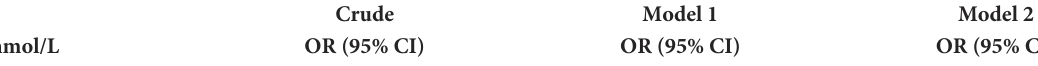
TABLE 3 Serum folate in relation to MAFLD according to vitamin C status. Crude Serum folate, nmol/L OR (95% CI) OR (95% CI) Serum folate in relation to MAFLD according to vitamin C status (CAP scores ≥ 248 dB/m)